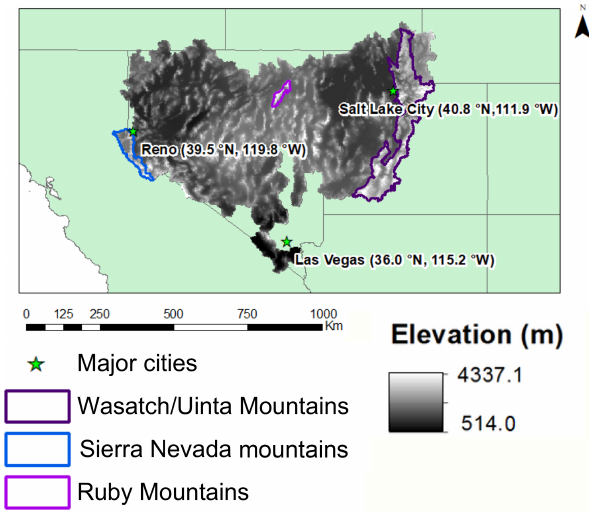
Figure A1. Map of the Great Basin region, USA, as defined by the USGS HUC Region 16 along with major cities and mountain ranges. The Sierra Nevada, Ruby, and Wasatch–Uinta mountain ranges are highlighted.